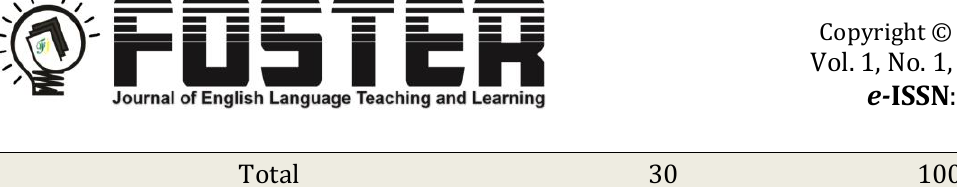
Table 4.23 The Rate Percentage Score of Students' Fluency in Posttest Result in Control Class Classification